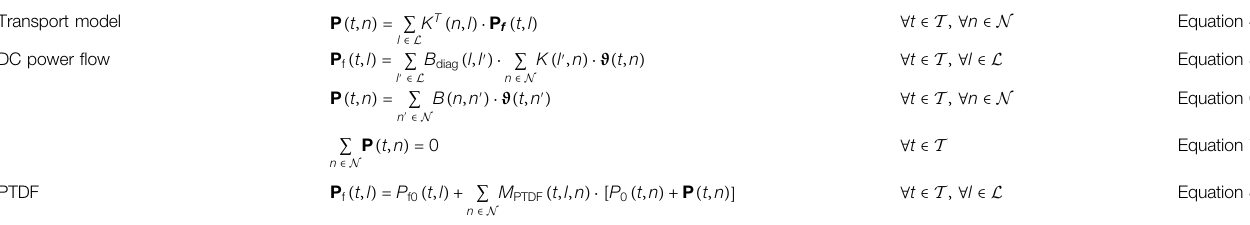
TABLE 4 | Implementation of power fl ow approaches in REMix: transport model, DC power fl ow, and PTDF. Transport